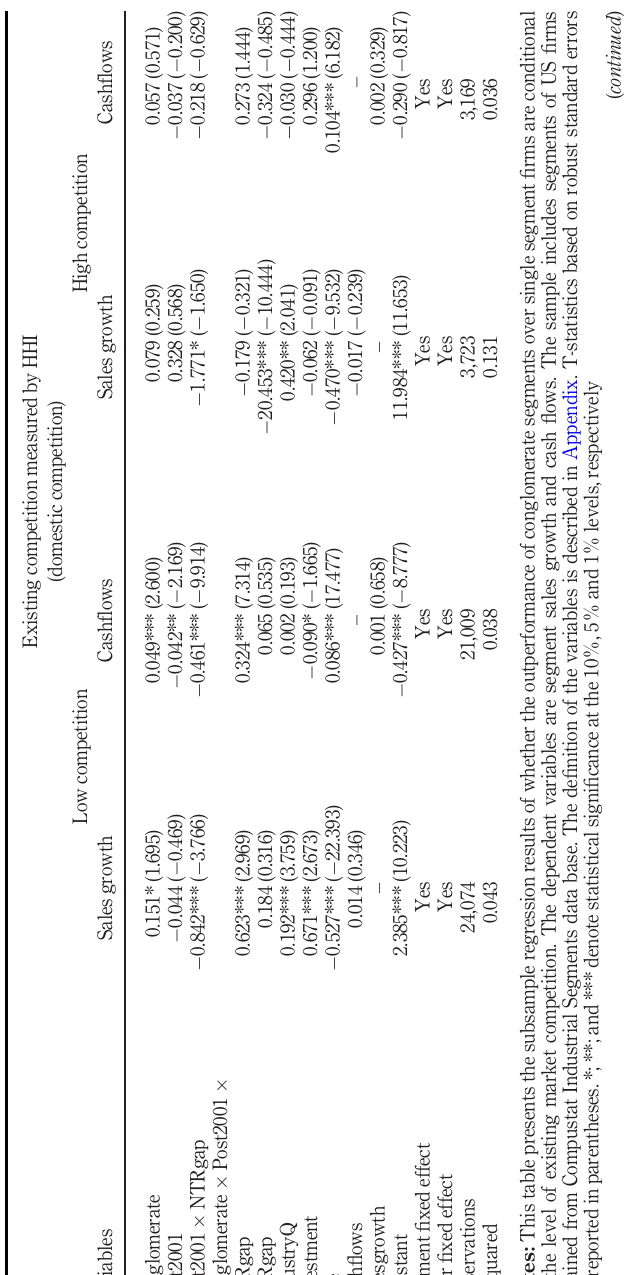
Table 4. Does the level of existing competition matter in determining conglomerate